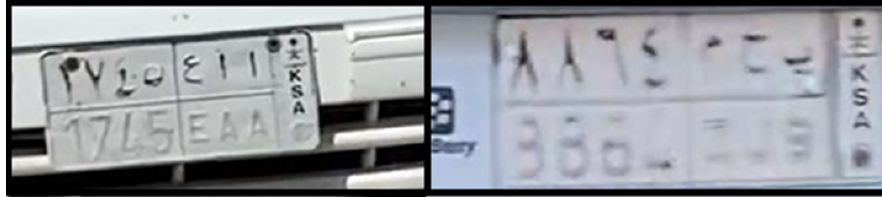
Figure 15. Worst visibility conditions.